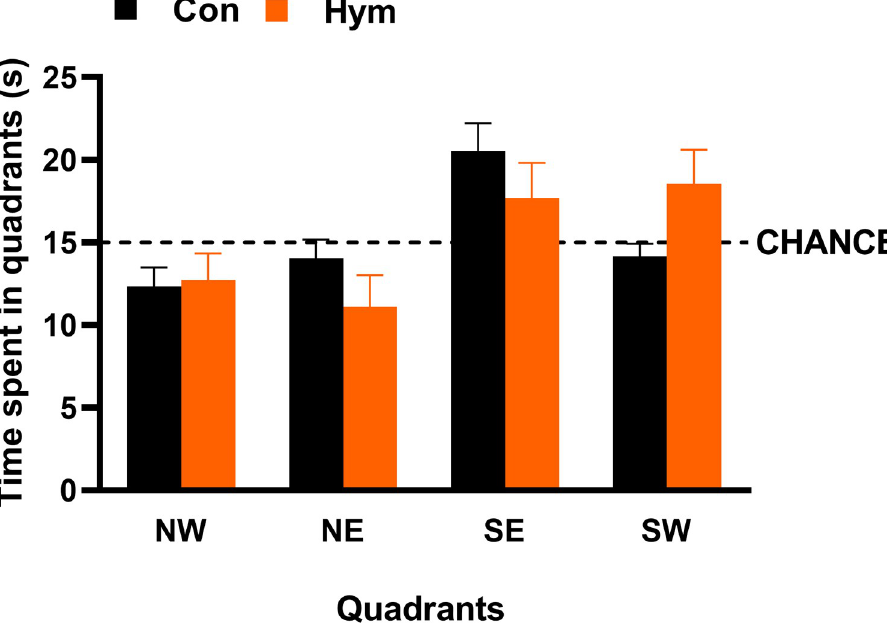
Fig 5. Time spent in each four quadrants during the second memory probe trial of water maze (day 10) of control rats (Con, n = 8) and rats infected with H . diminuta (Hym, n = 7). The horizontal dashed line marks chance